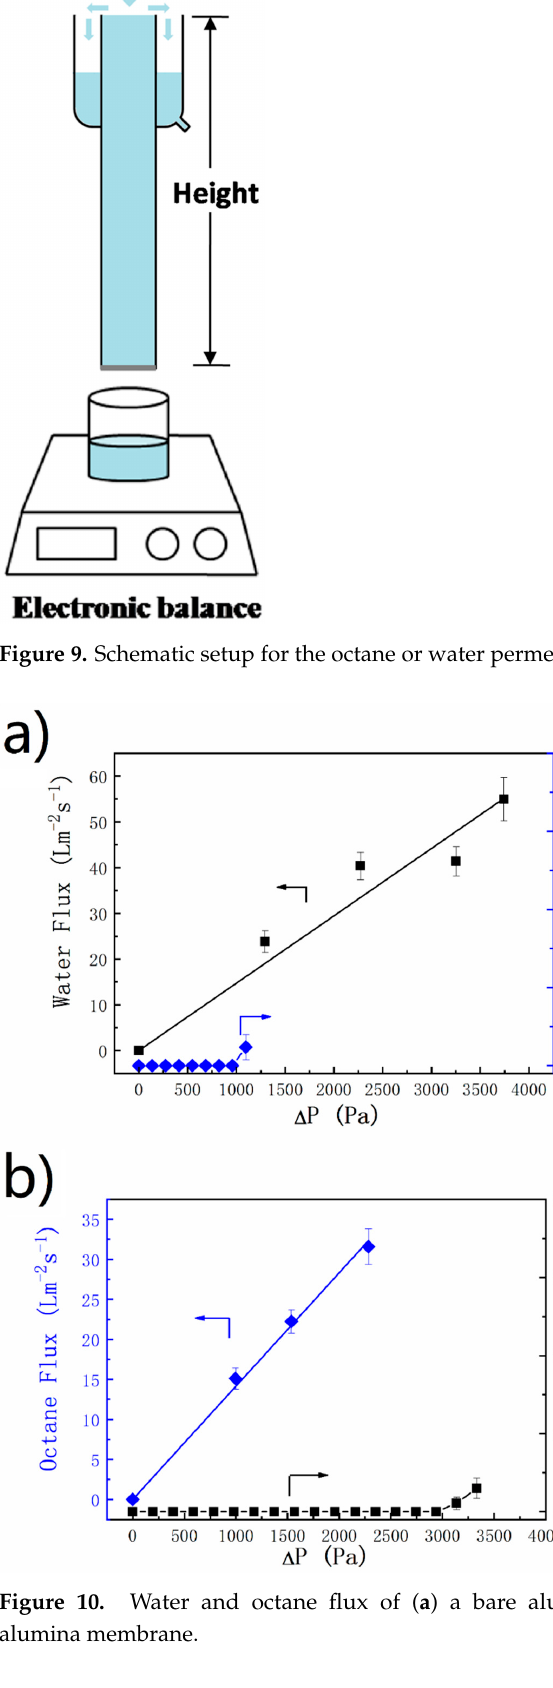
Figure 10. Water and octane flux of ( a ) a bare alumina membrane and ( b ) a FAS-grafted alumina